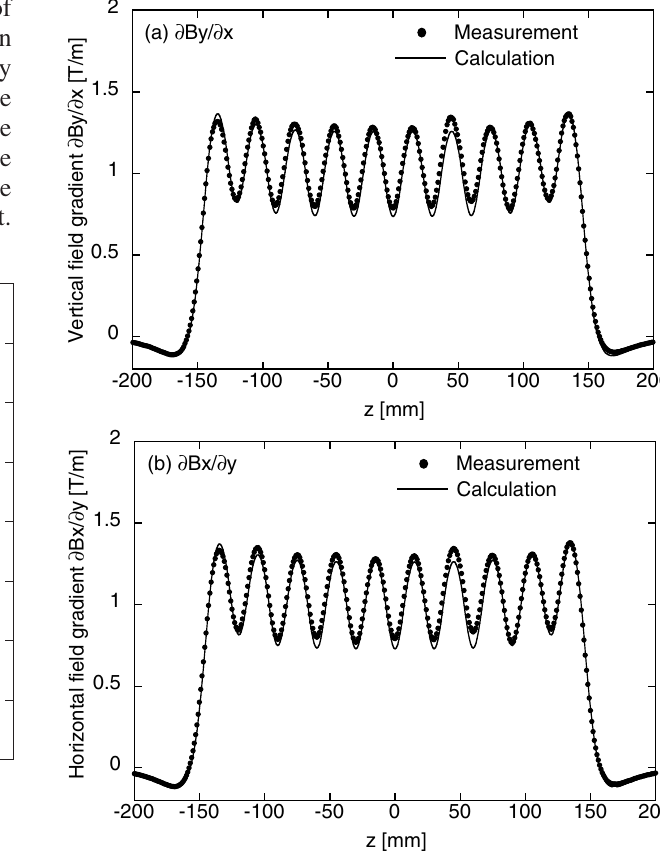
ð x; y ¼ 0 ; z ¼ 0 Þ as a func- y FIG. 8. Field gradients of the EF wiggler along the wiggler =@x ) and (b) horizontal one axis: (a) vertical field gradient ( @B y =@y ). The solid circles and the solid lines show the mea- ( @B x sured field gradients and the calculated ones,